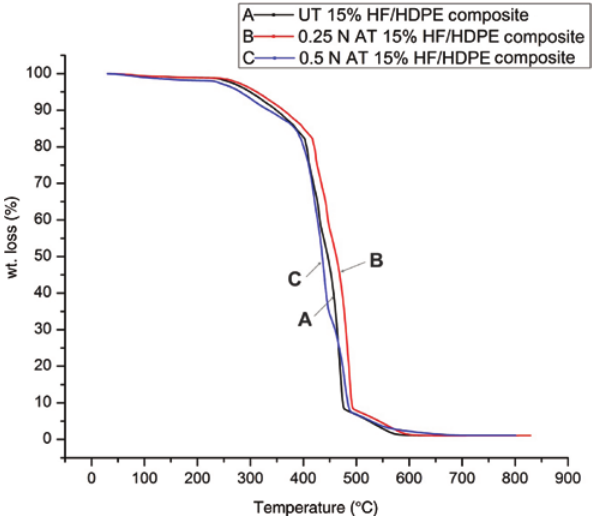
Figure 5: TGA thermograms of untreated and treated 15% HF/HDPE composites.